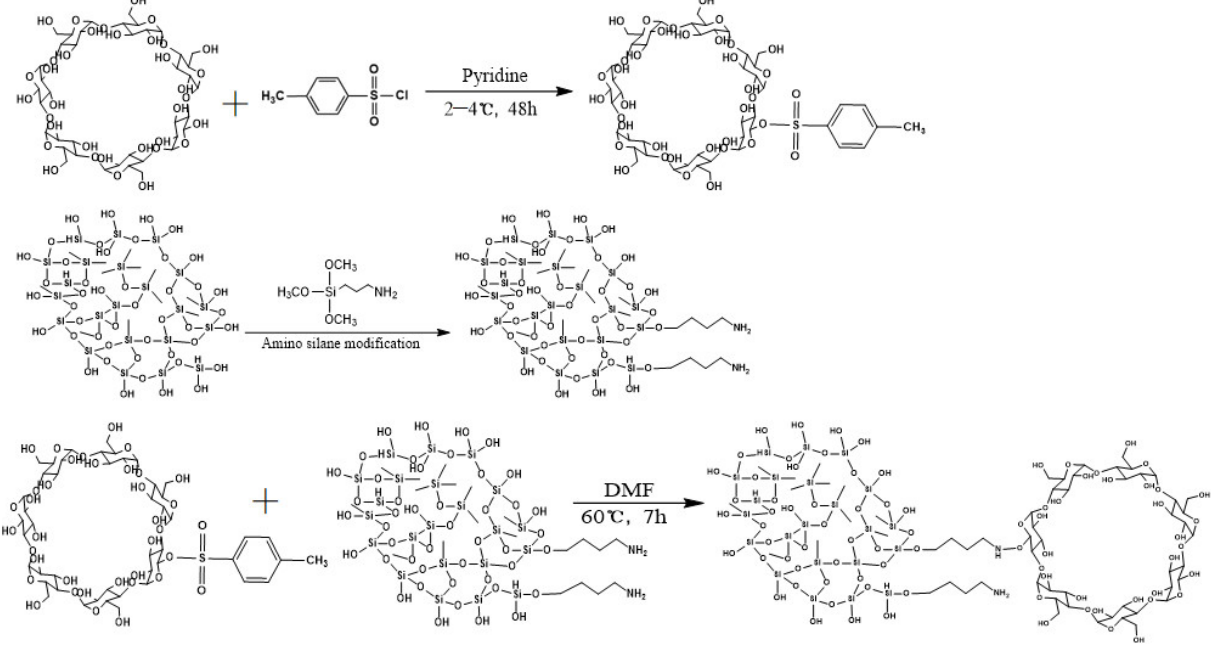
Figure 1. Reaction process of DA/ β -CD